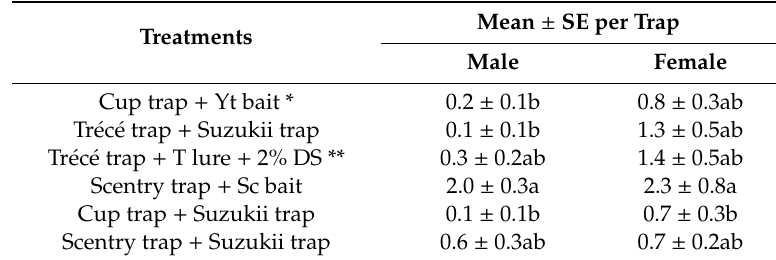
Figure 6. Spotted-wing drosophila flies captured in blackberry planting from 4 June 2015 to 2 July 2015 in Citra, Florida. The letters above the bar indicate significant differences ( p ≤ 0.05). C trap = Cup trap, Yt = Yeast bait, T trap = Trécé trap, T lure = Trécé lure, Sc trap = Scentry trap, Sc bait = Scentry lure, Sz bait = Suzukii trap, and 2% DS = 2% detergent solution. * Reference treatment. Table 5. Male and female adults captured in blackberry planting from 4 June 2015 to 2 July 2015 in Citra,